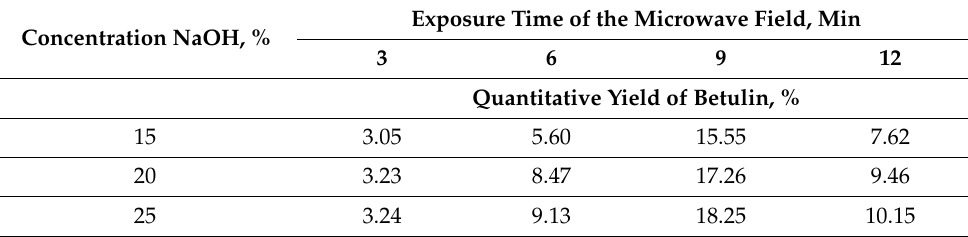
Table 2. Data on the yield of betulin extracted by the microwave field method, %. Concentration NaOH,